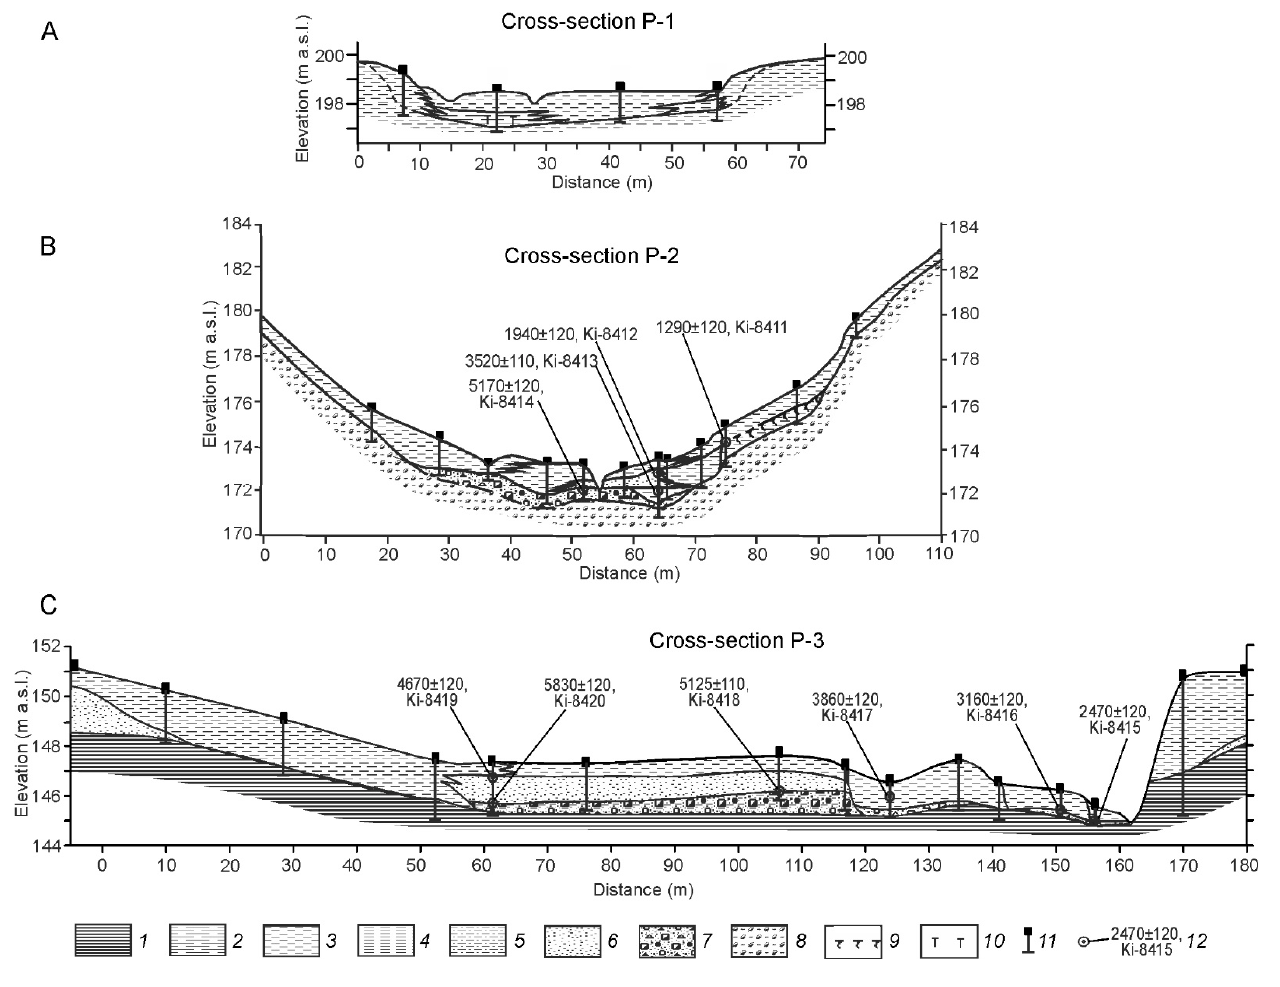
Figure 12. Keys: 1—clay, 2—heavy loam, 3—medium and light loam, 4—silt, 5—sandy loam, 6—mixed-grained sand, 7—boulder–pebble–gravelly mixture with sand filler, 8—boulder loam, 9—buried soil, 10—peat formation, 11—cores, 12— 14 C samples and dates.